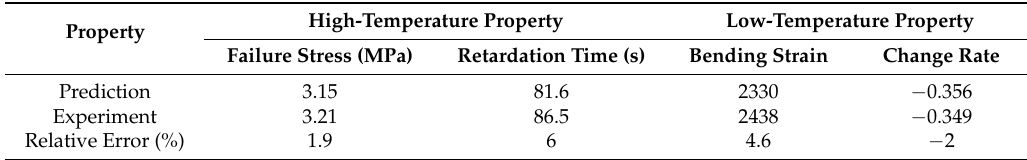
Table 11. Optimal value of multi-response for asphalt